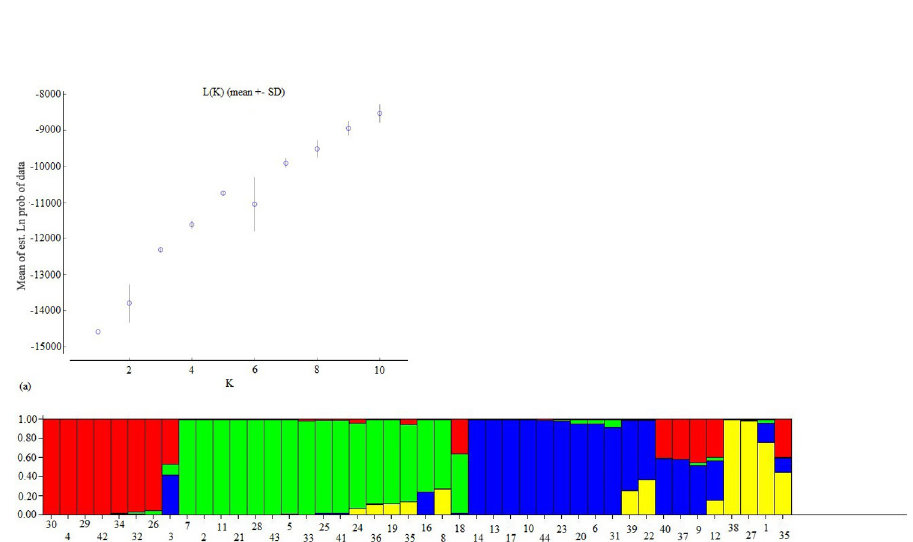
Fig 1. SNPs markers characteristics. (a) Distribution of SNPs across the 11 chromosomes. (b) Polymorphic Information Content (PIC). (c) Variation of Gene Diversity. (d) Frequency distribution of Major Allele Frequency.